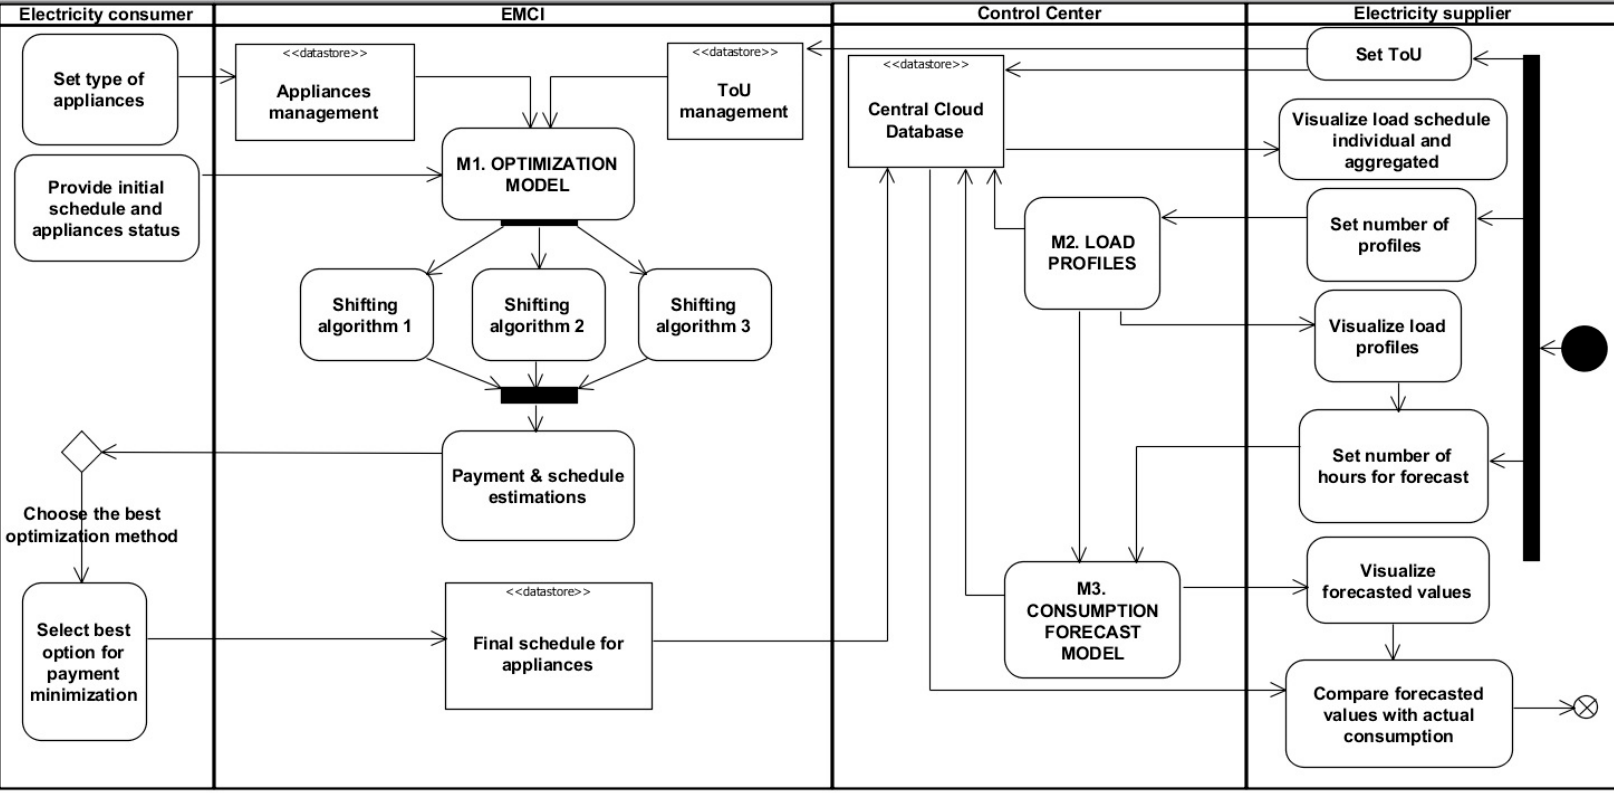
Figure 3. Flowchart of the models and algorithms.